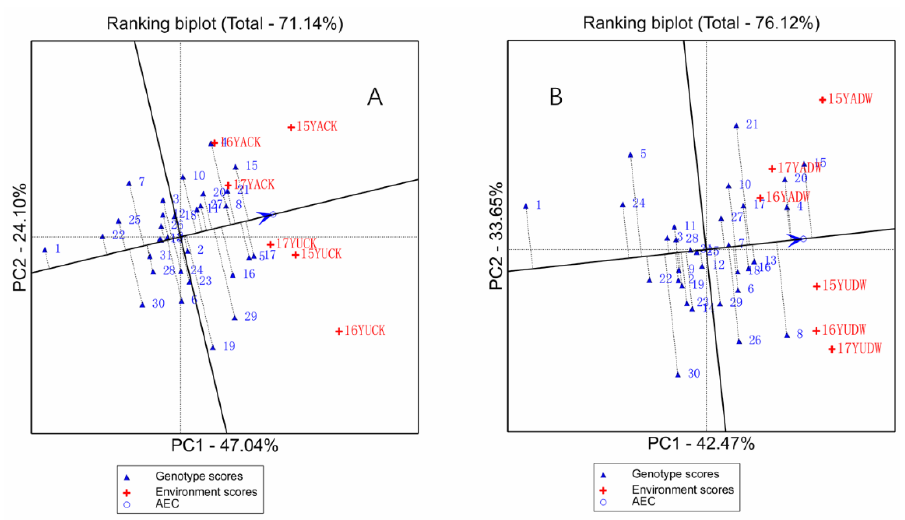
Figure 4. Mean vs. stability GGE biplots for normal conditions ( A ) and drought treatments ( B ).